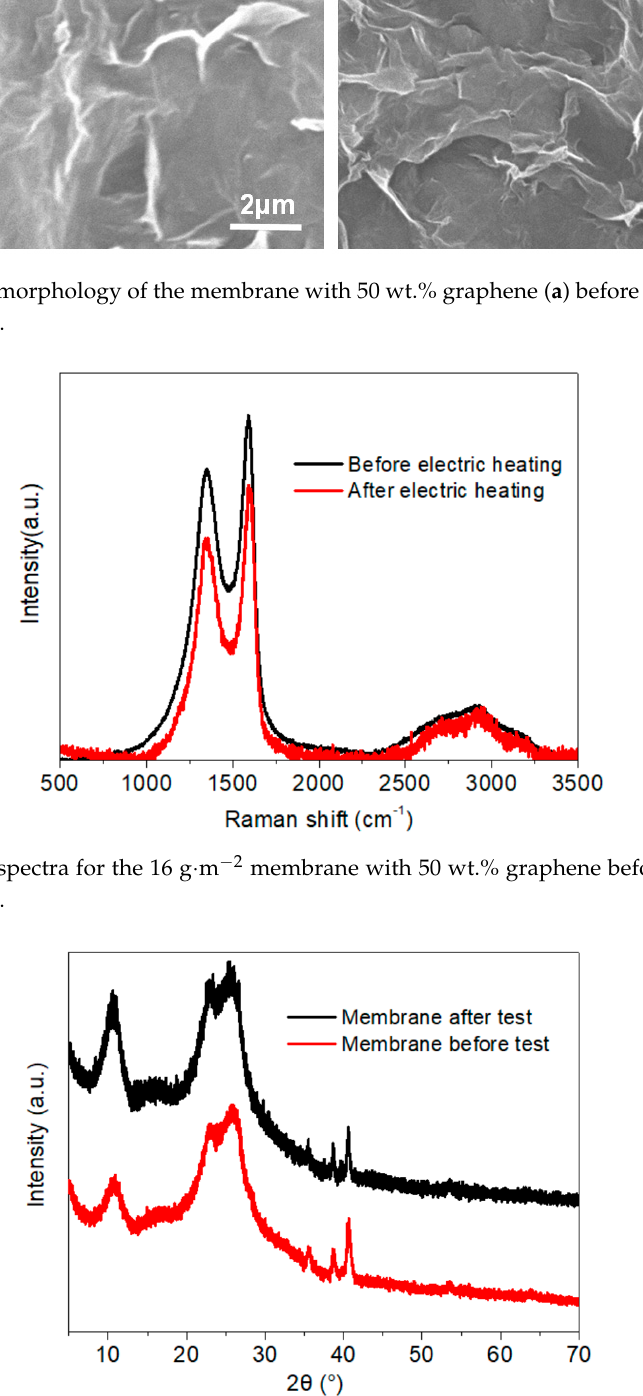
Figure 20. XRD spectra for the 16 g·m − 2 membrane with 50 wt.% graphene before and after the electric heating test.